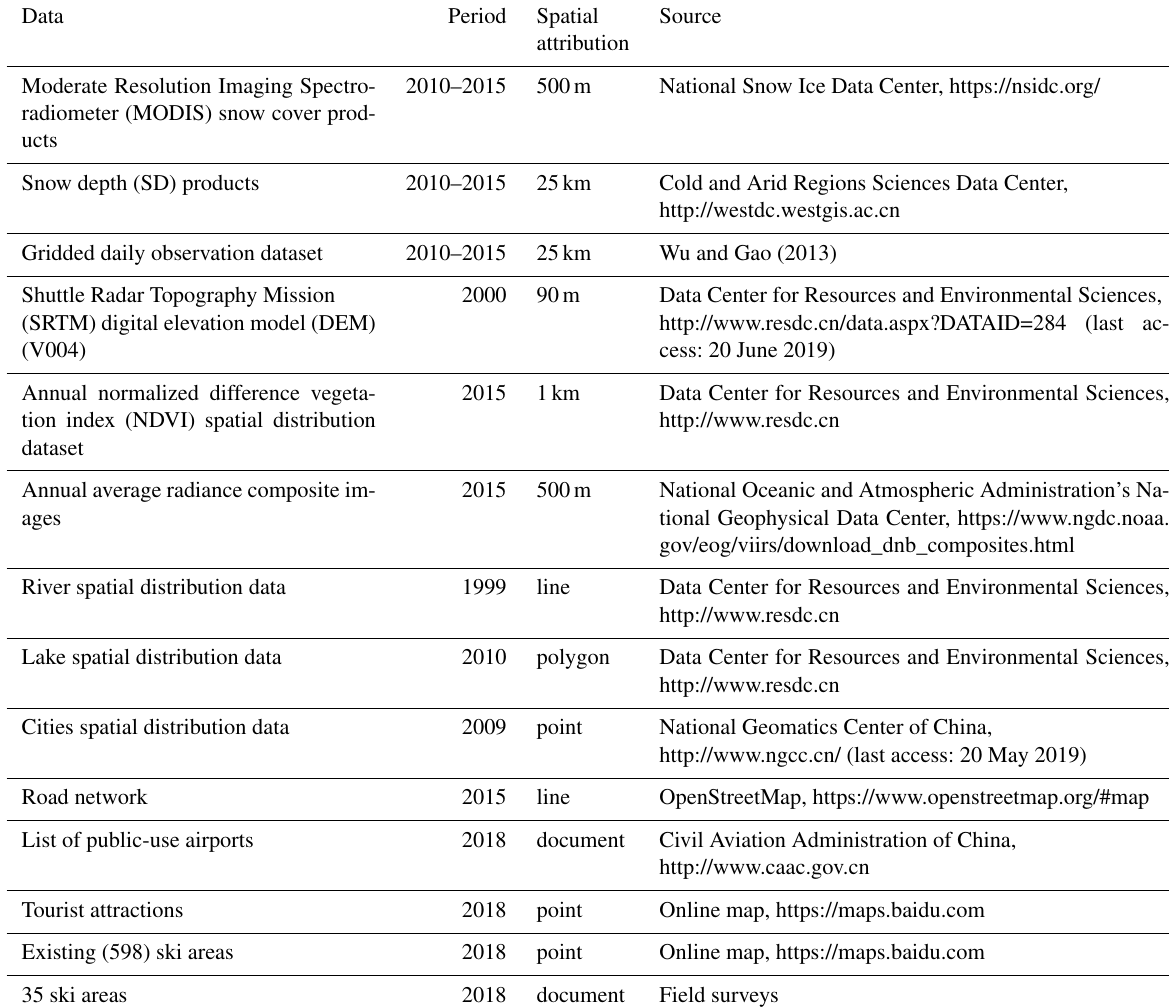
Table 1. Descriptions of the data used in this study.